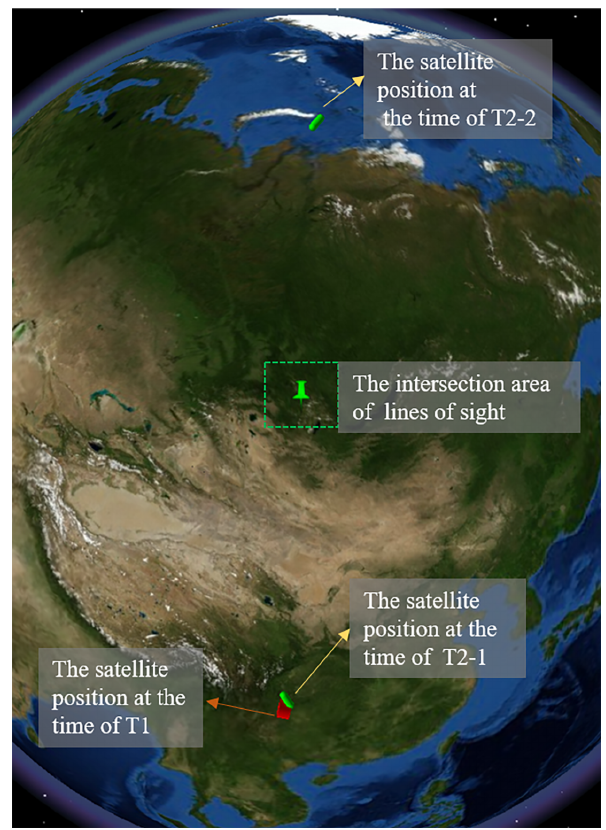
Figure 5. Please check new figure. Relative location of the DSHS by the three-dimensional limb mode. There are two locations of the satellite at the time of T2 which meet the requirement of the three- dimensional limb mode. Map data: ©Google Earth, Image IBCAO, and